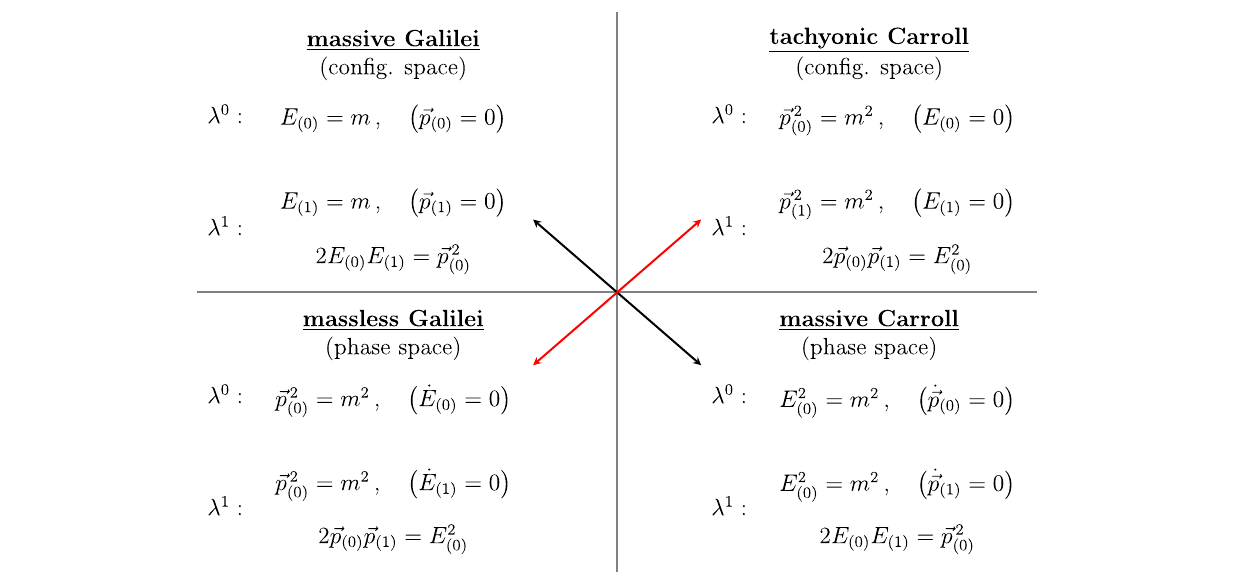
FIGURE 1 | Diagram showing schematically the relation between the different non-relativistic limits for different types of particles. The focus is here on the constraintsobeyed bythe canonical variables. Wehave usedthe letter m foralltypes ofmasses thatappear. Inthecase ofthemasslessGalileiparticlethiscorresponds to the colour k , see Eq. 4.14 . The conditions shown in parentheses correspond to the ones that arise from using the same number of time and space variables as explained in the